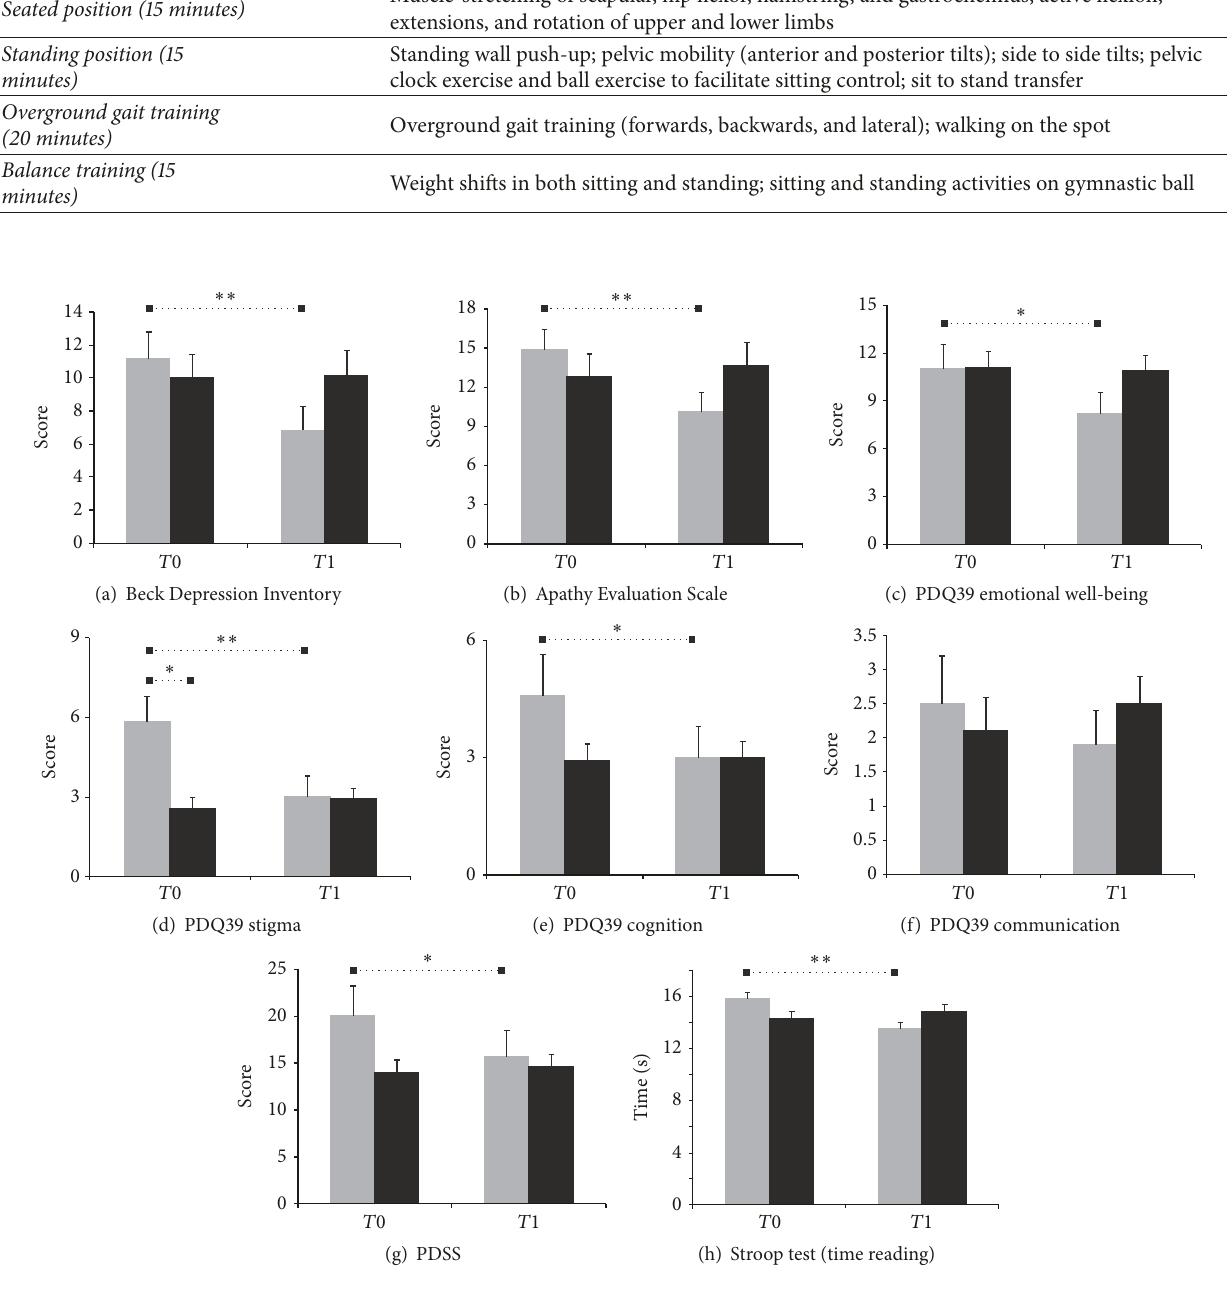
Figure 1: Mean scores and standard error of the means at the two time points for the theatre (gray bars) and control group (black bars) in the scales or subscales showing a significant effect at the mixed-design ANOVAs (see text and Table 5 for more details). Bars indicate significant differencesafterposthocanalyses,thesingle ∗ indicatesvaluesof 𝑝 < 0.01 ,andthedouble ∗ indicatesvaluesof 𝑝 < 0.001 .PDQ39:Parkinson’s Disease Quality of Life Scale; PDSS: Parkinson’s Disease Sleep